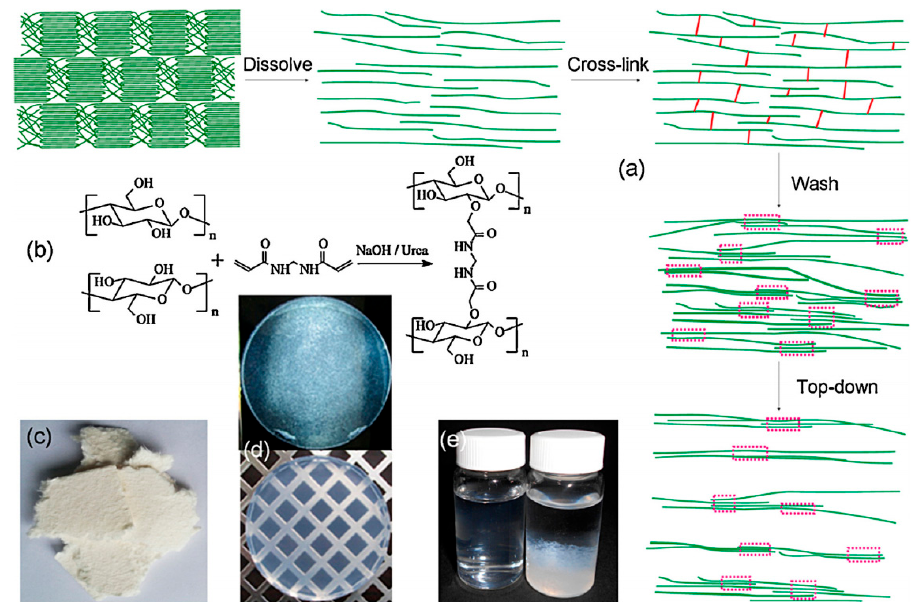
Figure 3. ( a ) Schematic diagram of hydrogel prepared by dissolving and cross-linking cellulose; ( b ) chemical equation of cellulose cross-linking reaction in NaOH/urea aqueous medium; ( c ) photo of hydrogel after washing of cross-linked cellulose; ( d ) the image on the left is an aqueous dispersion of chopped cellulose hydrogel, and ( e ) the image on the right is a distilled water dilution chart of the cellulose solution [37].